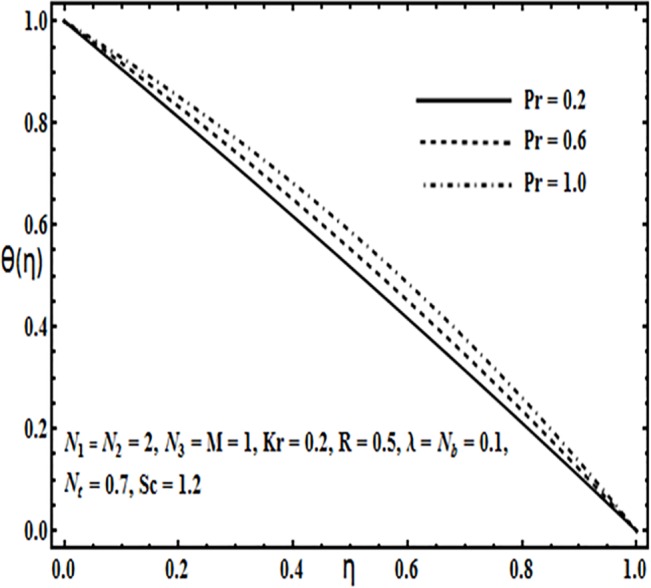
Effect of Pr on θ(η).